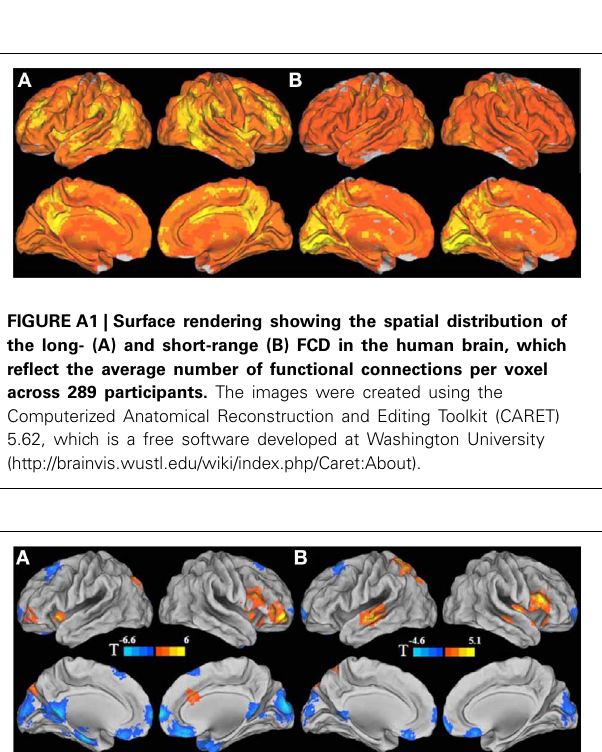
FIGURE A2 | Gender effect for long-range FCD (A) and for short-range FCD (B). For the purpose of presentation, cool color represents the regions showing reduced long- or short-range FCD in men, and warm color represents the regions showing reduced long- or short-range FCD in women. Statistical values were T values for the simple